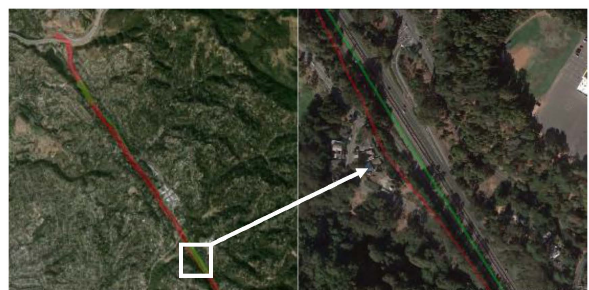
Figure 5. The smartphone’s GPS data has been shown in red and ground truth in green. The error of measured GPS position exceeds 50 meters in some regions.